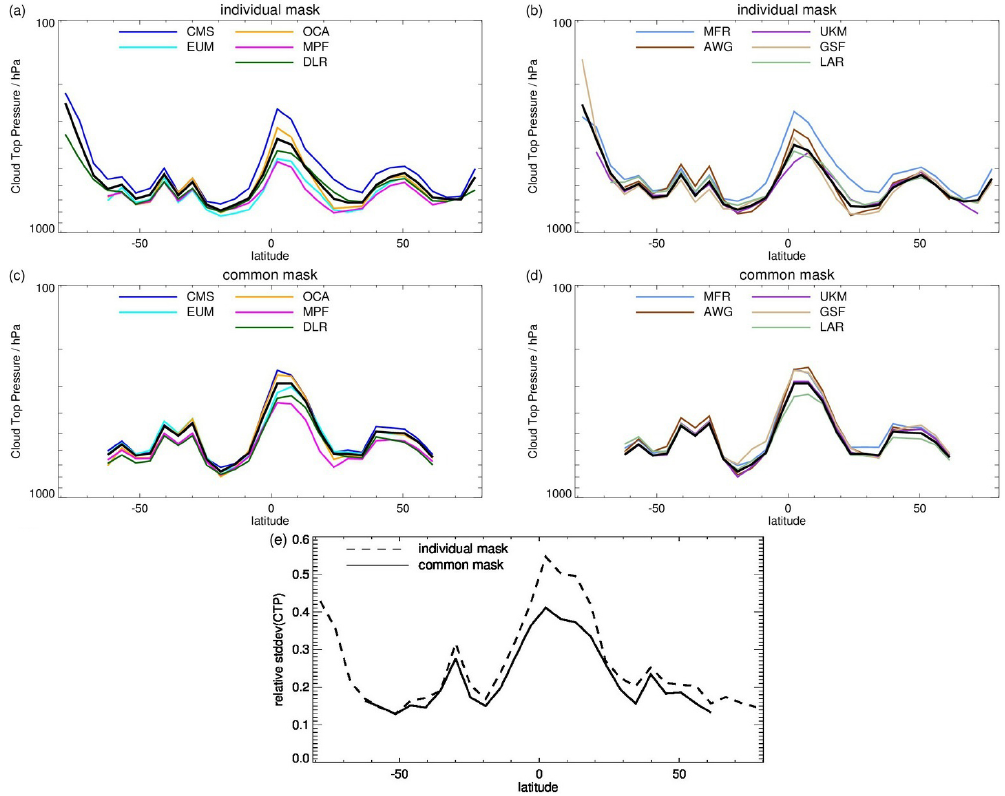
Figure 3. Latitudinal mean of the cloud top pressure of ten algorithms for 13 June 2008, 12:00–15:00UTC. In panels (a) and (b) the original data sets are used, whereas in panel (c) and (d) the data sets are reduced to observations, for which all ten retrievals detect a cloud and derive a CTP. The black line shows the average of all SEVIRI algorithms. In the lower panel (e) the relative standard deviations of the algorithm ensemble are